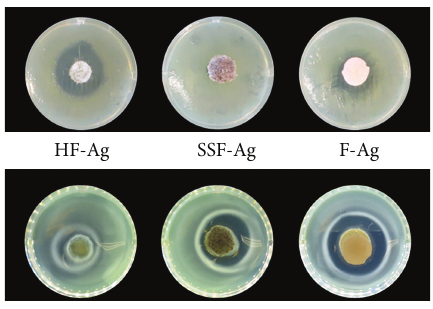
Figure 1: Test specimens containing different silver compounds were applied on Muller-Hinton (MH) agar (top row) as well as on 3D synthetic soft tissue (SST) (bottom